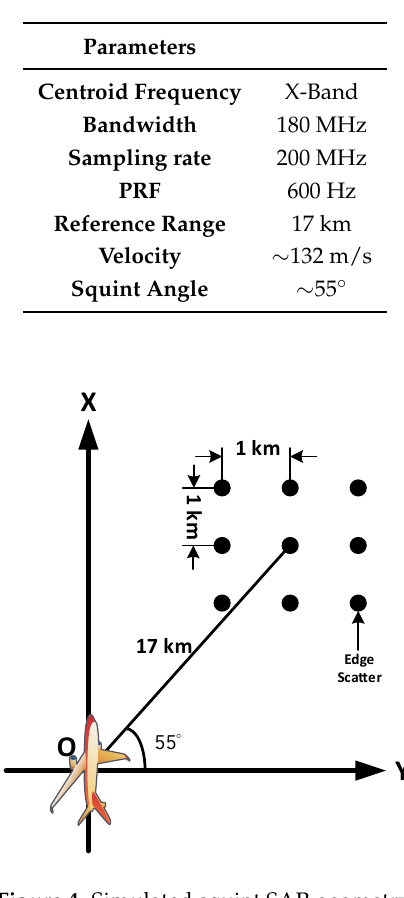
Figure 4. Simulated squint SAR